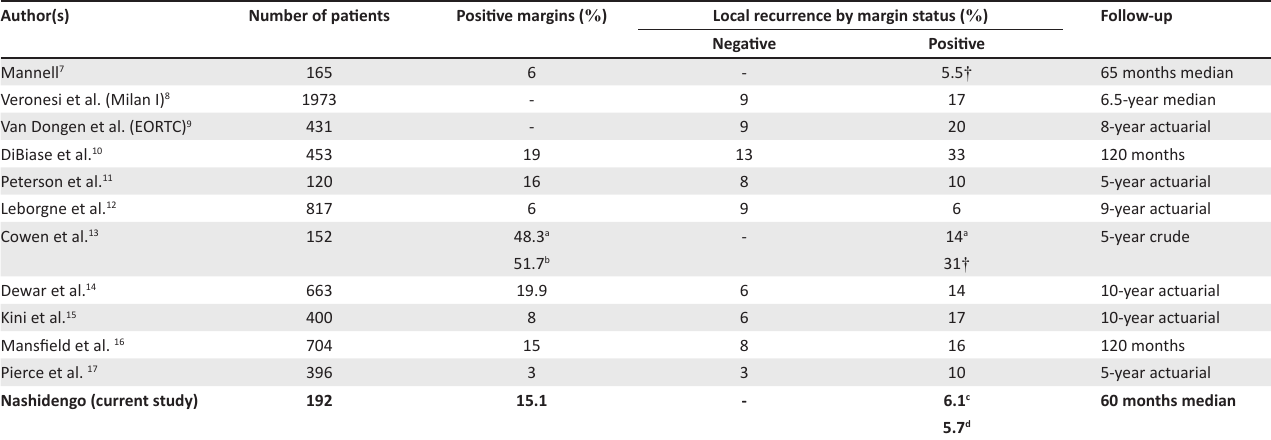
TABLE 4: Studies on positive margins and local recurrence by margin status.